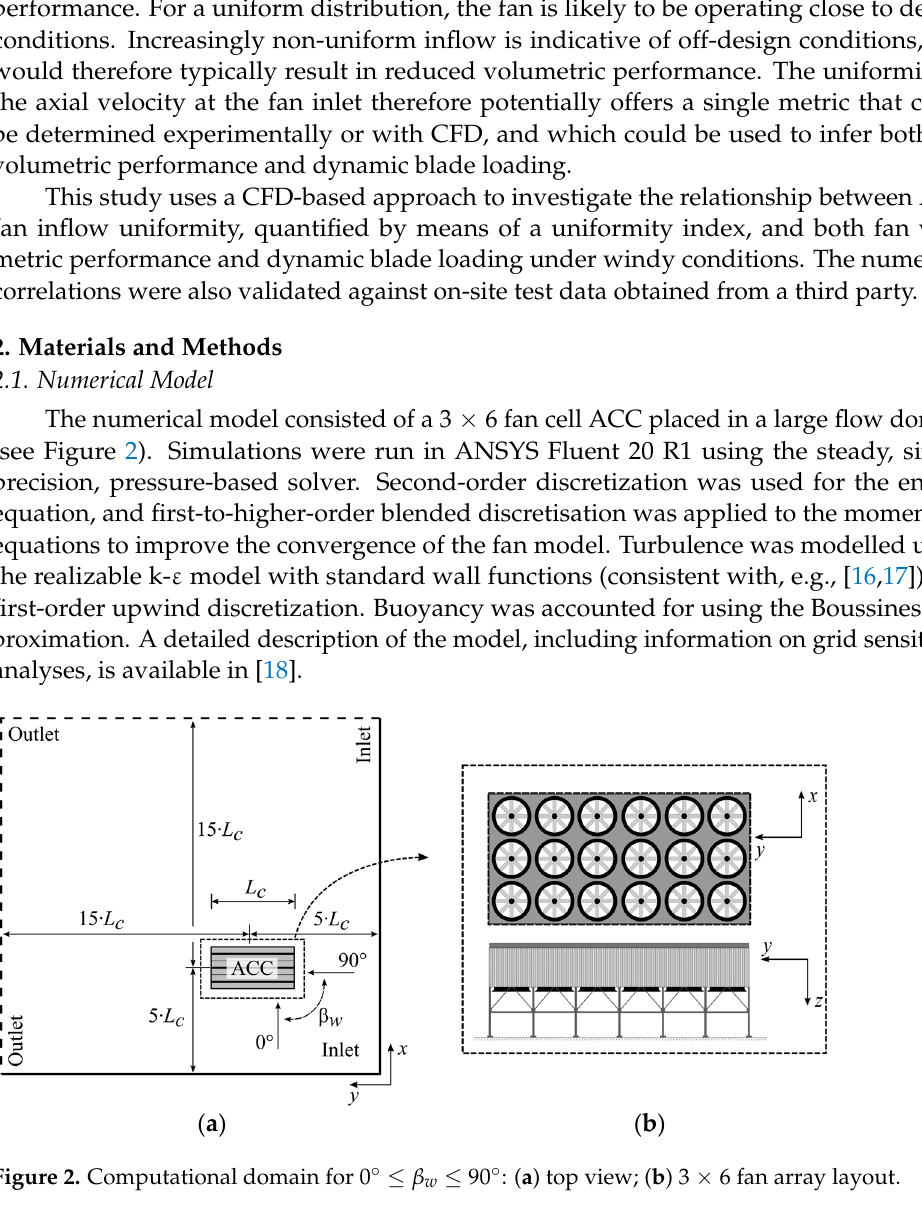
◦ : ( a ) top view; ( b ) 3 × 6 fan array w ≤ 90